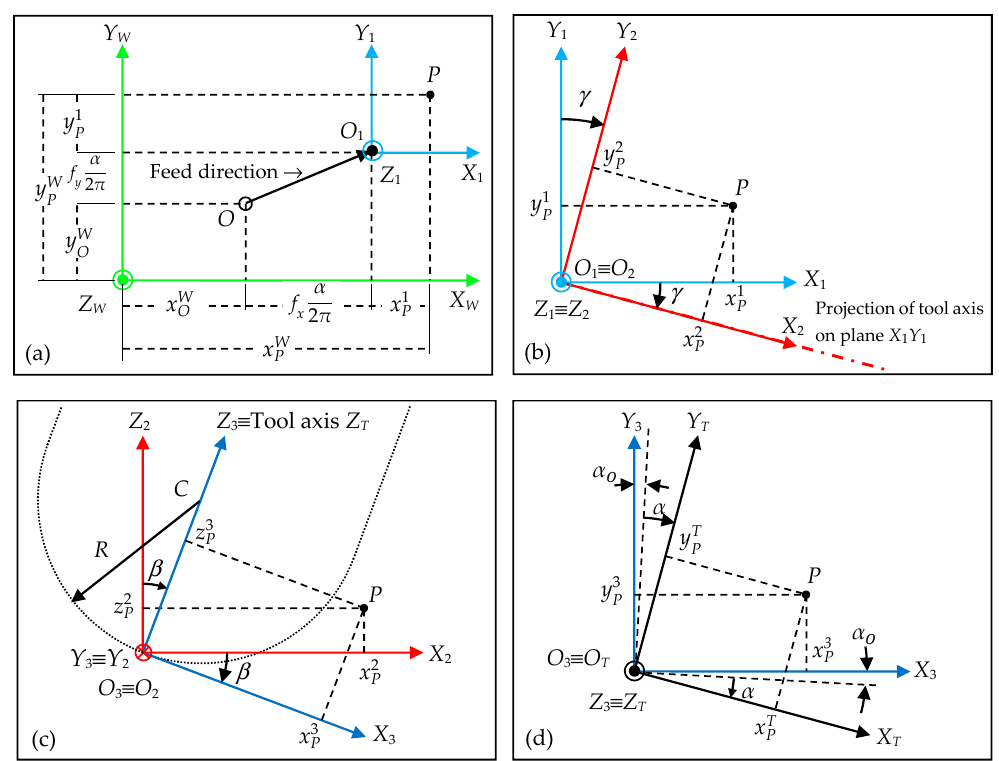
area are obtained through the procedure described in Step 7.